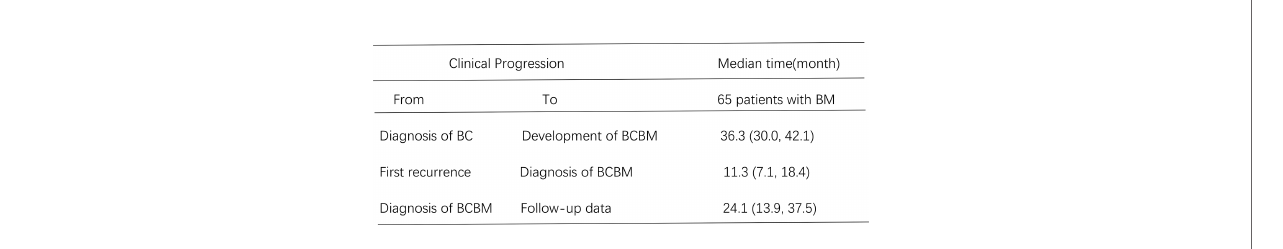
FIGURE 2 | Different clinical progression of median time for 65 Her 2 positive breast cancer patients with BM.